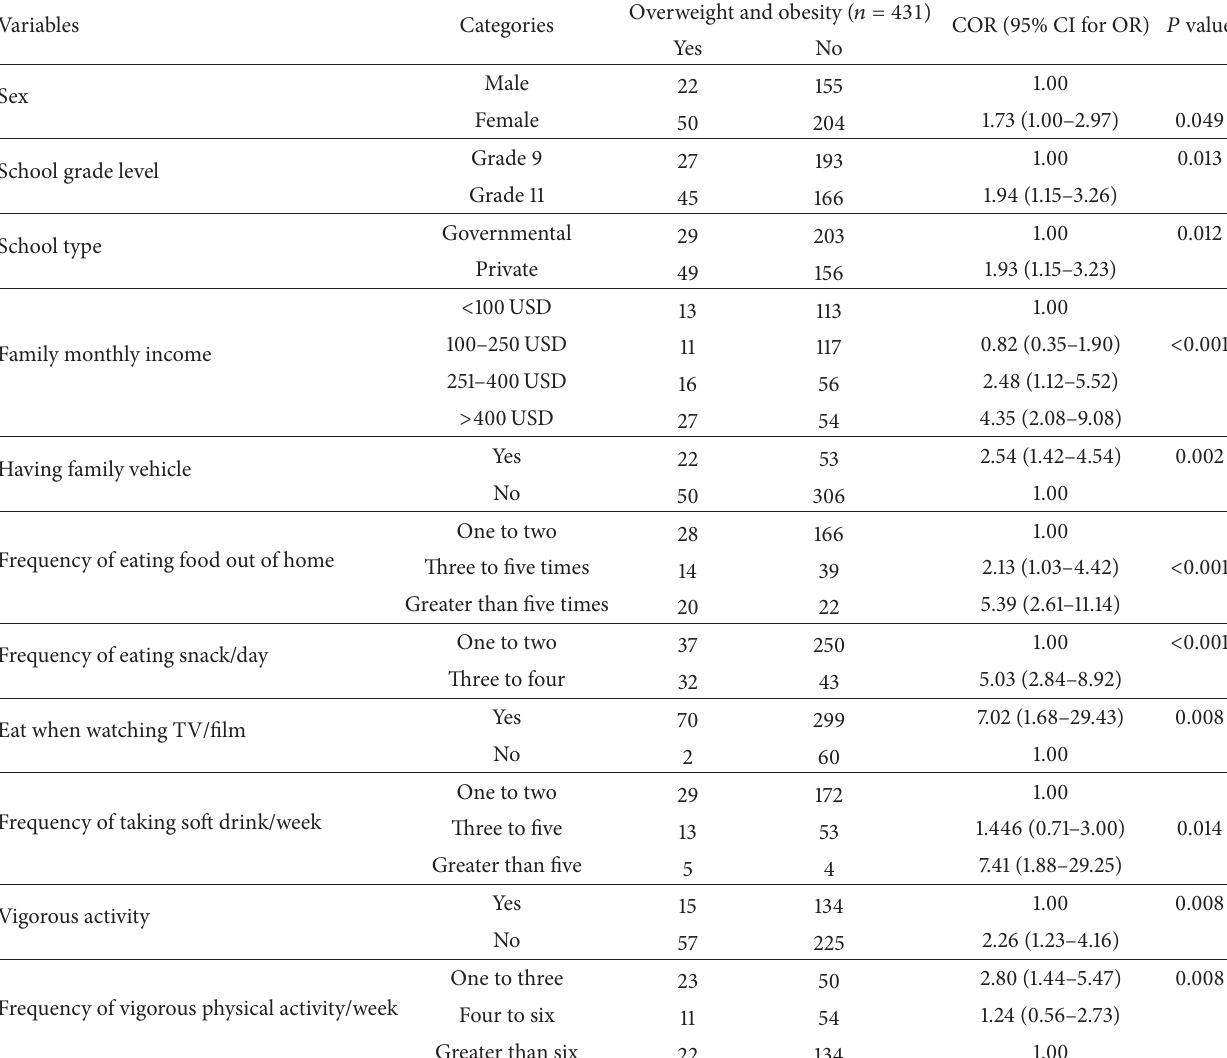
Table 5: The correlation between selected predictor variables and overweight and obesity on crude effect among high school students in Bahir Dar city,